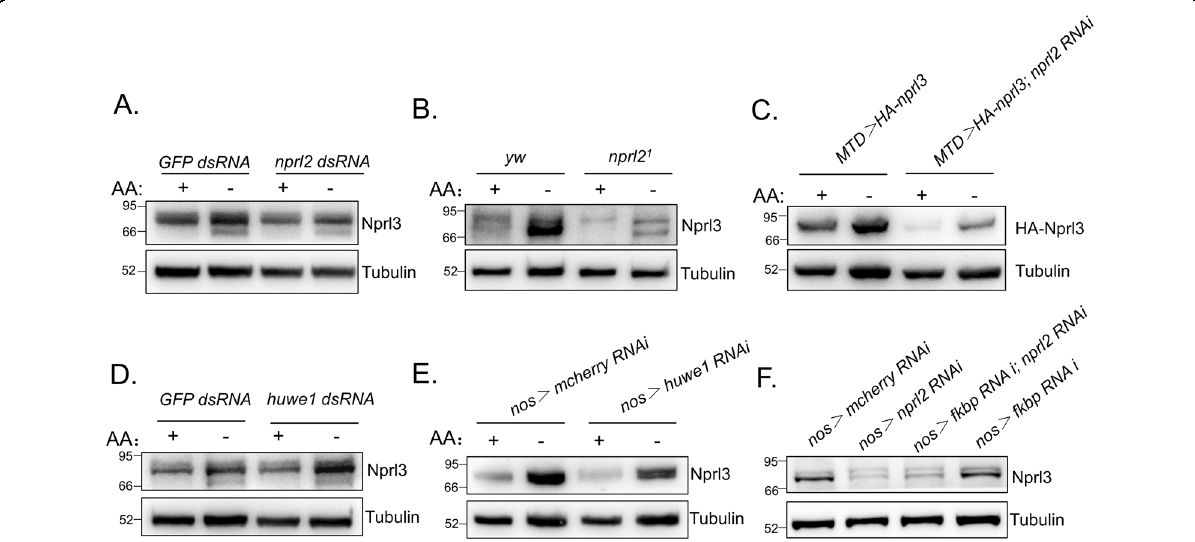
Fig. 6 Nutrient signal and USPD independently controls Nprl3 stability. A S2 cells were transfected with GFP (control) or nprl2 dsRNA. Cells were treated with amino acid starvation for 2 h. The levels of Nprl3 were detected by western blot. B The ovaries from yw (control) and nprl2 1 were dissected and cultured in amino-acid-free Schneider ’ s medium (AA − ) for 2 h. The levels of Nprl3 were detected by western blot. C . The ovaries from MTD > Nprl3-HA (control) and MTD > Nprl3-HA, nprl2 RNAi were dissected and cultured in amino-acid-free Schneider ’ s medium (AA − ) for 2 h. The levels of HA-Nprl3 were detected by western blot. D S2 cells were transfected with GFP (control) or huwe1 dsRNA. Cells were treated with amino acid starvation for 2 h. The levels of Nprl3 were detected by western blot. E The ovaries from nos > mCherry RNAi (control) and nos > huwe1 RNAi were dissected and cultured in amino-acid-free Schneider ’ s medium (AA-) for 2 h. The levels of Nprl3 were detected by western blot. F Western blot analysis of Nprl3 protein in the ovaries of Nos > mCherry RNAi (control), Nos > nprl2 RNAi, Nos > nprl2 RNAi, fkbp39 RNAi and Nos > fkbp39 RNAi fl ies. α - Tubulin was used as a loading control. Similar western blot results were observed in more than three independent experiments for each